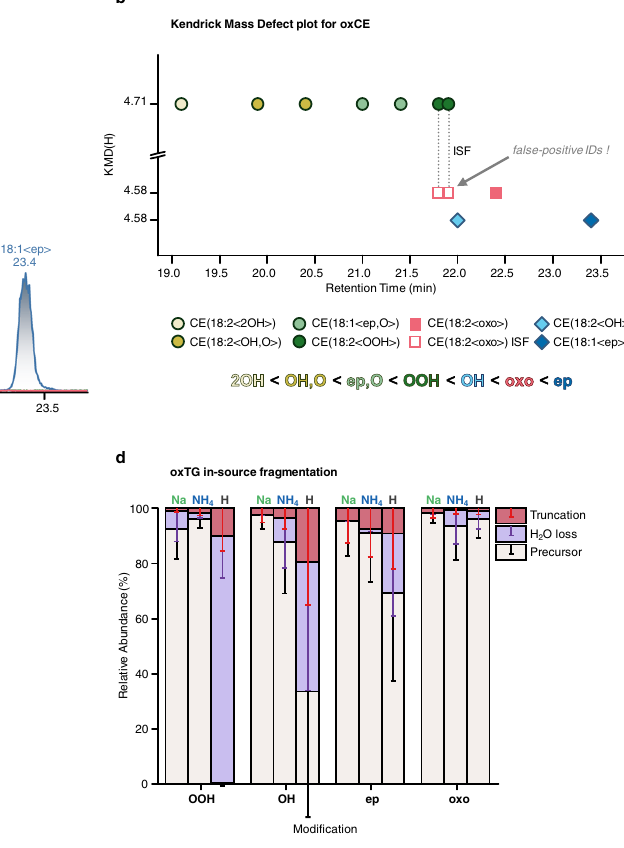
Fig. 3a for C13-OOH <C9-OOH, and Supplementary Fig. 1 for mono- oxygenated PC(16:0_20:4<OH>) isomers). Baseline separation of regioisomerswas notpossible for majority ofthe species,however use of extracted chromatograms of position-speci fi c fragment ions allowed accurate assignment of corresponding retention times (RTs).